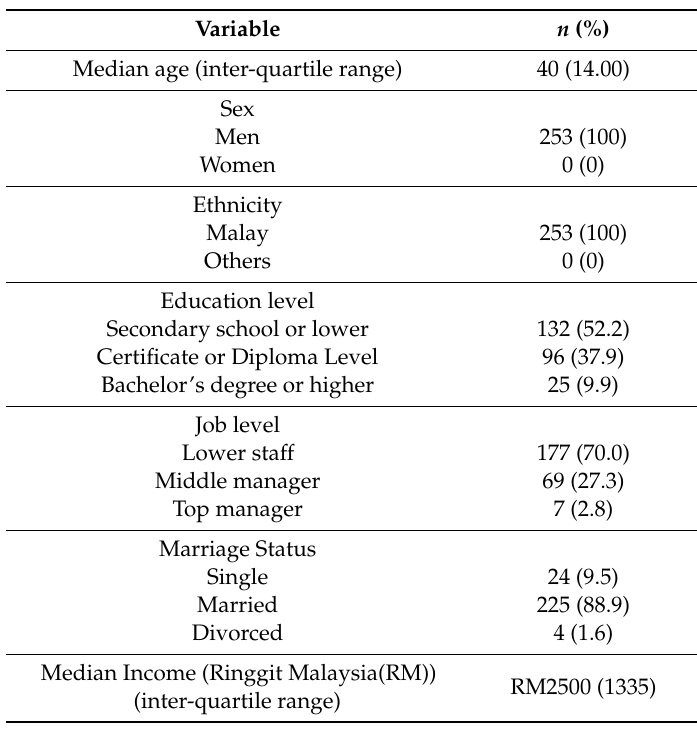
Table 3. Socio-demographic characteristics of the participants ( n = 253).